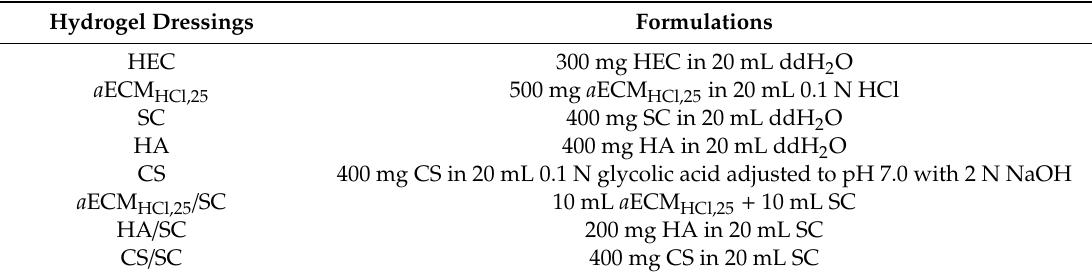
Table 2. Formulations of hydrogel